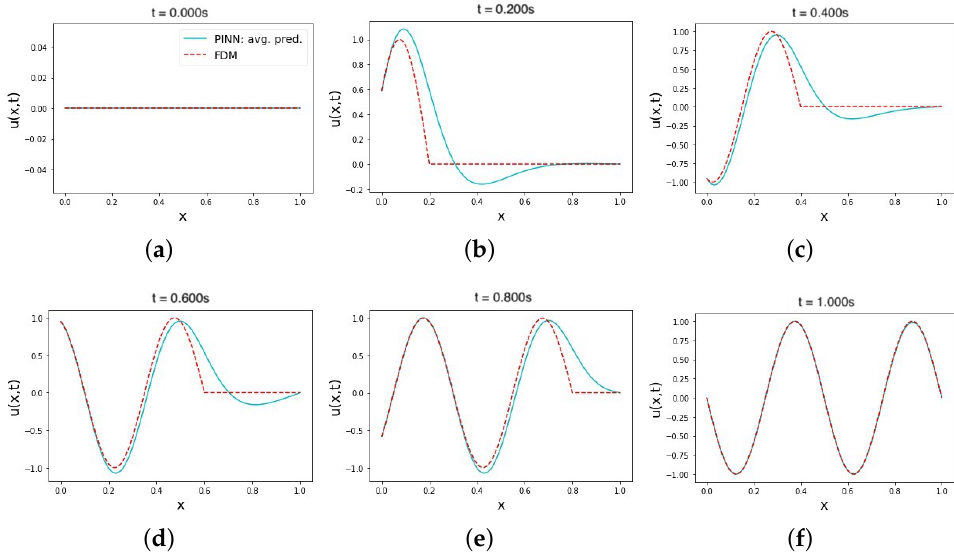
Figure 2. The average solution prediction of the wave equation using a PINN with hard–hard ICs and BCs. Plots ( a – f ) show the average of six trials in multiple time instances in the range [0, 1] after removing the four outliers. All training points are sampled uniformly from the domain in all